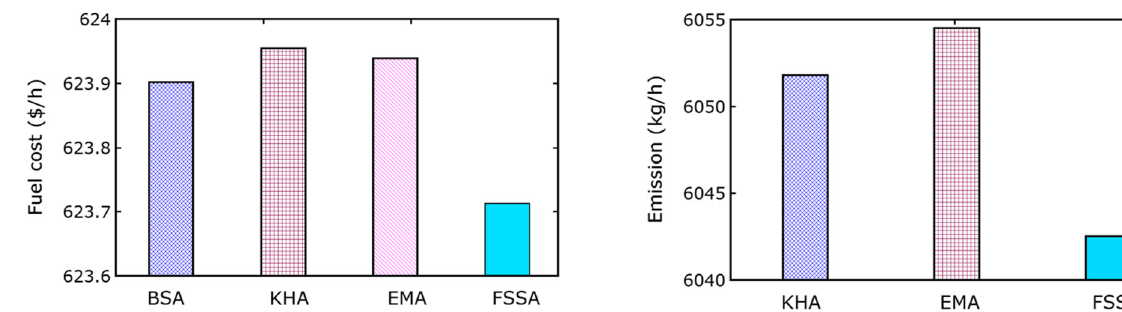
Fig. 3 Performance comparison of the FSSA approach with